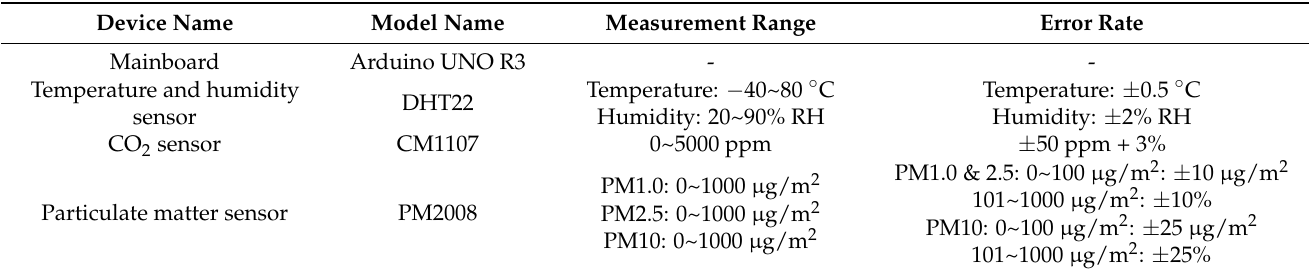
Figure 2. Comprehensive sensor module for environment measurement. Table 2. Qualification of each sensor.